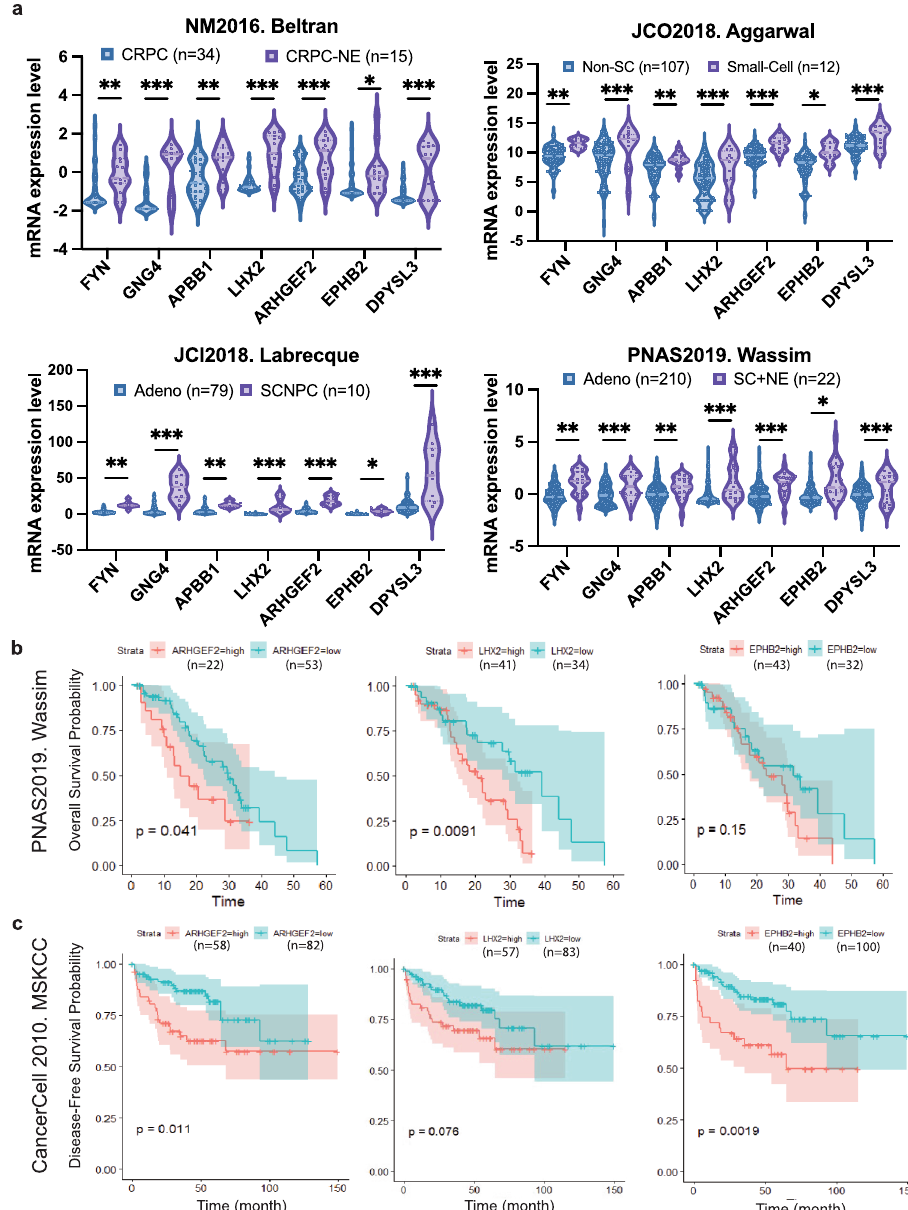
Fig. 5 Upregulated neural lineage genes correlate with poor overall survival in prostate cancer patients. a Gene expressions of the seven neural lineage signature genes were presented in the indicated groups of Beltran, Aggarwal, Labrecque, and Wassim cohorts. Gene expression from CRPC patients in Beltran study, prostate adenocarcinoma samples from Aggarwal, Labrecque, and Wassim study were presented in blue, while that of CRPC-NE samples from Beltran study, small-cell neuroendocrine prostate cancer from Aggarwal, Labrecque and Wassim studies was presented in purple. CRPC castration- resistant prostate cancer; CRPC-NE castration-resistant prostate cancer with neuroendocrine features; Adeno; non-SC non-small-cell prostate adenocarcinoma; Small-Cell small-cell neuroendocrine prostate cancer; prostate adenocarcinoma; SCNPC small-cell neuroendocrine prostate cancer; SC + NE small-cell neuroendocrine prostate cancer. * p < 0.05, ** p < 0.01, *** p < 0.001, using unpaired t -test (median, quartiles and dis t ribution of all data points presented). b Kaplan – Meier analysis of neural lineage signature genes including ARHGEF2 , LHX2 , and EPHB2 for the overall survival in